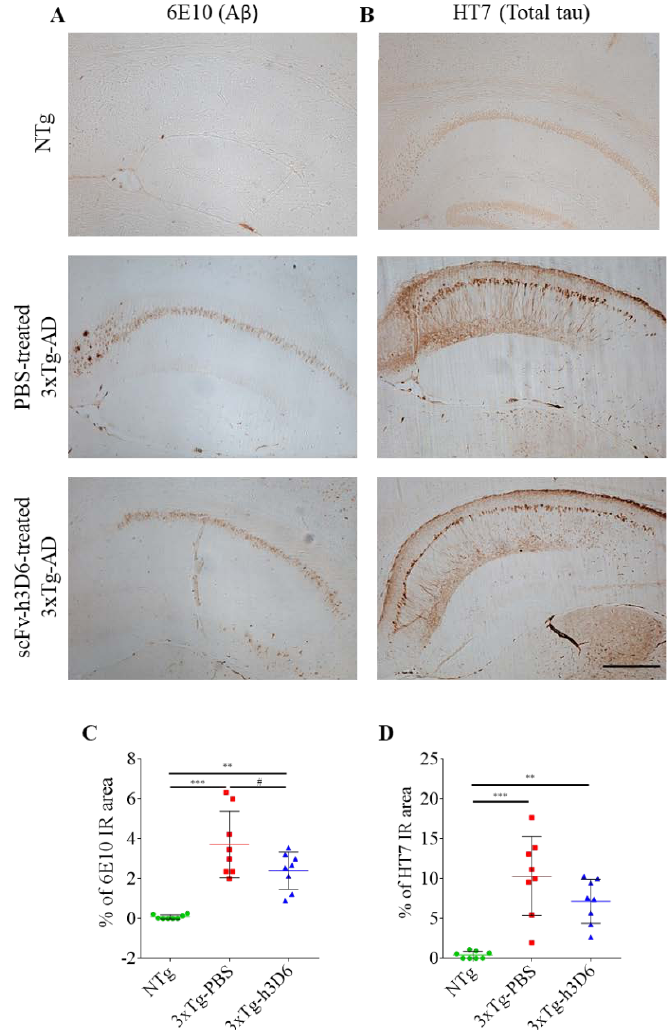
Figure 7. A β and tau deposition in 9-month-old 3xTg-AD hippocampus. ( A ) 6E10 (A β ) and ( B ) HT7 (total tau) staining in 9-month-old NTg, PBS-treated 3xTg-AD and scFv-h3D6-treated 3xTg-AD mice. Scale bar 200 µ m. ( C ) Percentage of 6E10 immunoreactive area in the hippocampus. ( D ) Percentage of HT7 immunoreactive area in the hippocampus. Values are represented by means and error bands correspond to SD. # indicates a low, but not significant, p -value (0.05 < p ≤ 0.1) (% of 6E10-immunoreactive area, 3xTg-AD-PBS vs. 3xTg-AD-scFv-h3D6, t = 1.932, p = 0.0738). ** p ≤ 0.01, *** p ≤ 0.001,